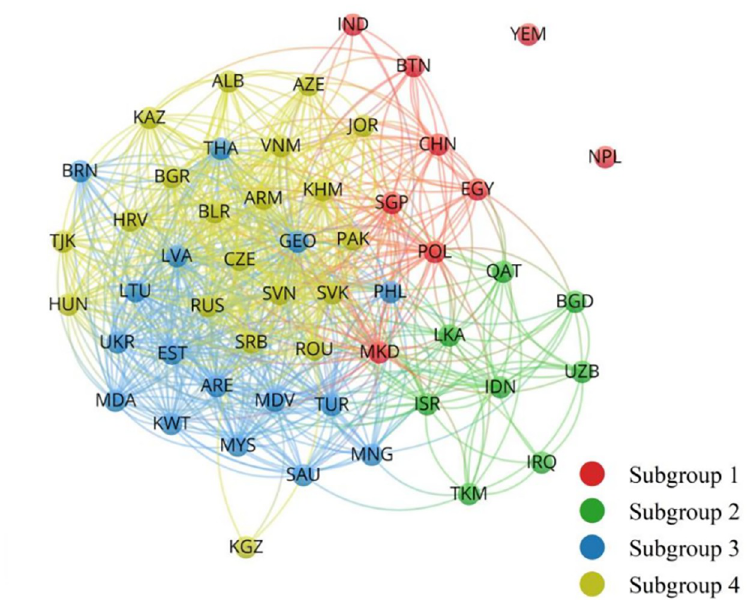
Fig 1. Network subgroups during 2000–2013. Source: Drawn by the authors from VOSviewer software.